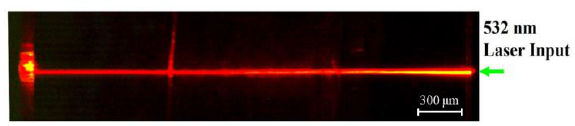
Fig. 3. Overhead microscope view of ‘static exposure’ waveguide showing the streak of fluorescence emission along the length of the waveguide.